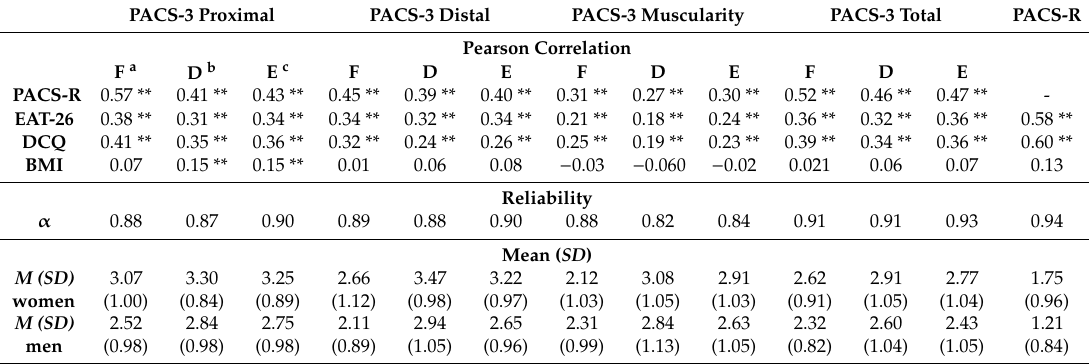
Table 2. Pearson correlation coe ffi cient, reliability, and descriptive statistics for PACS-3 and PACS-R. PACS-3